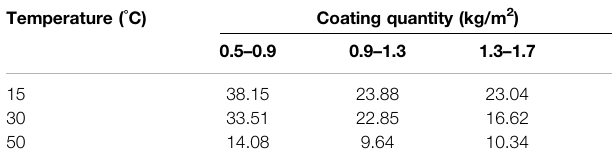
TABLE 7 | Change rate of shear fatigue life with coating quantity ( × 10 4 m 2